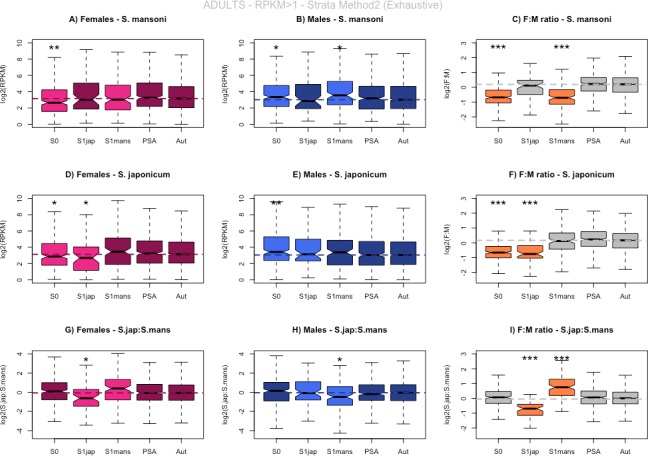
Adult expression patterns (RPKM>1, exhaustive strata) of genes located in the different strata of the Z (S0, S1man and S1jap), as well as pseudoautosomal and autosomal genes.The distribution of expression values is shown for (A) S. mansoni females, (B) S. mansoni males, (C) S. mansoni female:male, (D) S. japonicum females, (E) S. japonicum males, (F) S. japonicum female:male, (G) Female expression in S. japonicum divided by female expression in S. mansoni, (H) Male expression in S. japonicum divided by male expression in S. mansoni, (I) female:male ratio of expression in S. japonicum divided by female:male ratio of expression in S. mansoni. Asterisks represent levels of significance of comparisons to the control autosomal genes (*p-value<0.05, **p-value<0.001, ***p-value<0.0001). Genes were assigned to each Z-chromosome stratum based only on their coverage patterns; only genes with RPKM >1 were used.